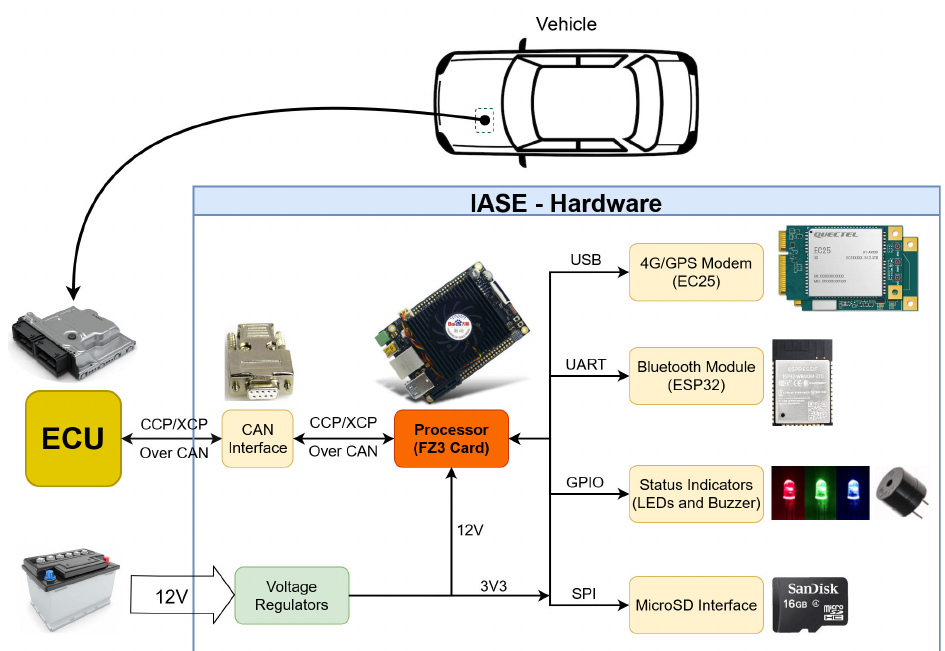
Figure 2. Block Diagram of IASE